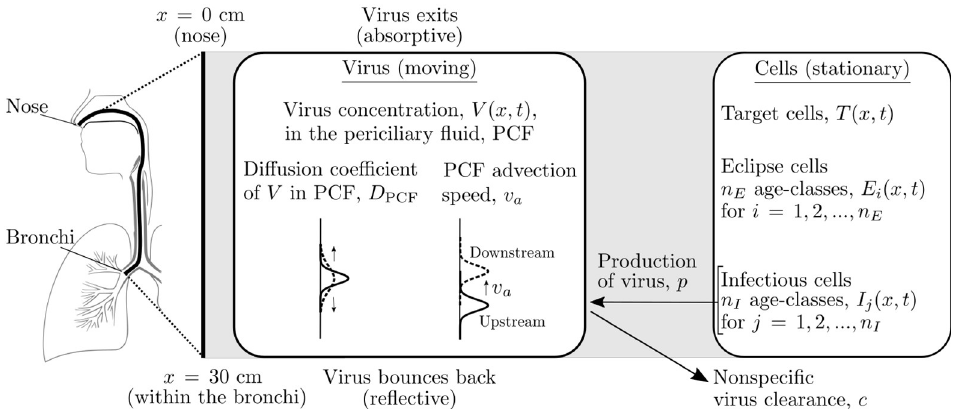
Fig 1. Representation of the human respiratory tract by the mathematical model. The MM Eq (1) represents the HRT as a one-dimensional track, as illustrated. The MM considers only the virus that is located in, and diffusing within the PCF, which also moves along with the PCF upwards at a fixed advection speed. What happens to the virus when it reaches the bottom (reflective) or top (absorptive) of the MM-represented HRT is indicated. MM (1) describes the interactions between the moving virus concentration in the PCF, and the stationary cells that carpet the